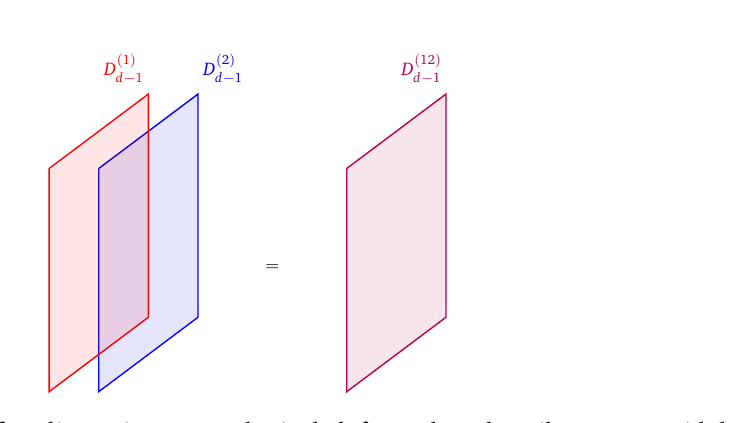
Figure 3: Fusion of codimension-1 topological defects that describes a monoidal structure on the objects in the symmetry higher-category.